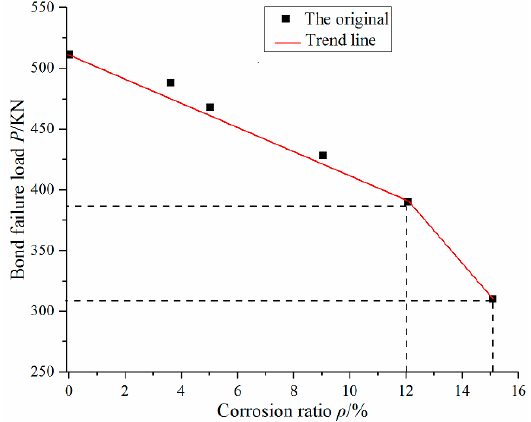
Figure 7. Relationship between corrosion ratio and bond failure load.